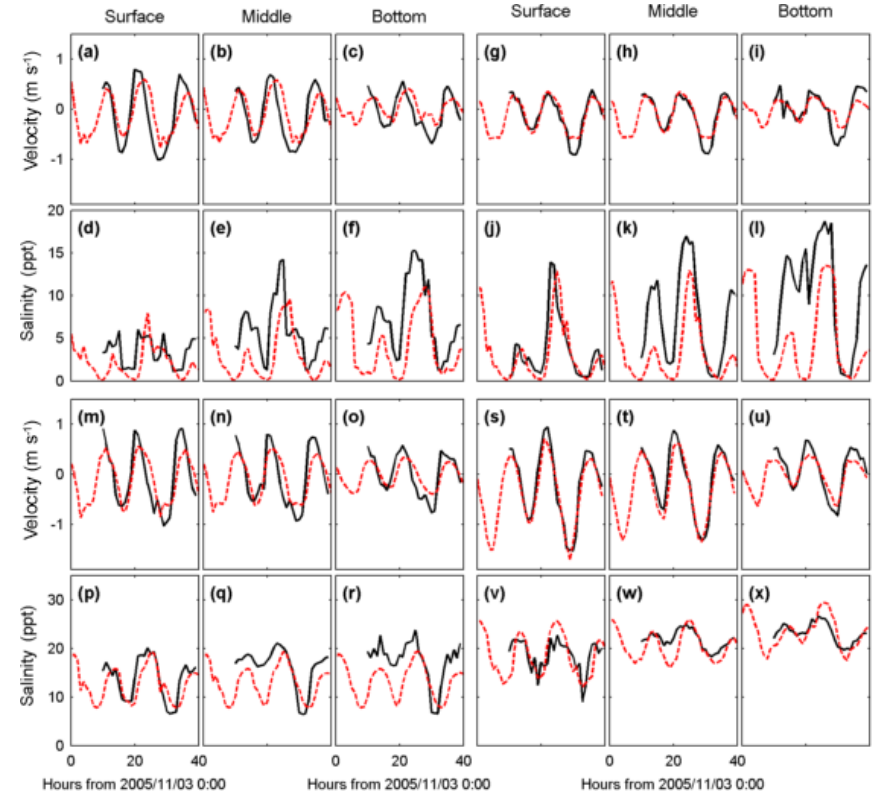
Figure 2. Model calibration for the period of 3–4 November 2005. Panels (a) – (c) show axial current; panels (d) – (f) show salinity at the surface, middle, and bottom layers at Station S2; panels (g) – (i) show axial current; panels (j) – (l) show salinity at Station S5; panels (m) – (o) show axial current; panels (p) – (r) show salinity at Station S6; panels (s) – (u) show axial current; and panels (v) – (x) show salinity at Station S9. The red dashed line shows the model results and the black solid line represents the observations.